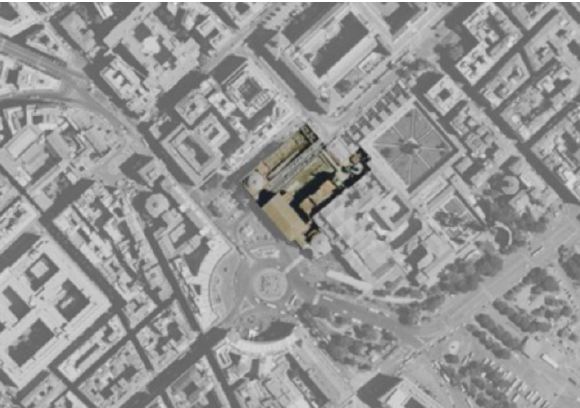
Figure 02 . Identification of the area under study, through the reworking of an aerial photo. In evidence the western sector of the Terme di